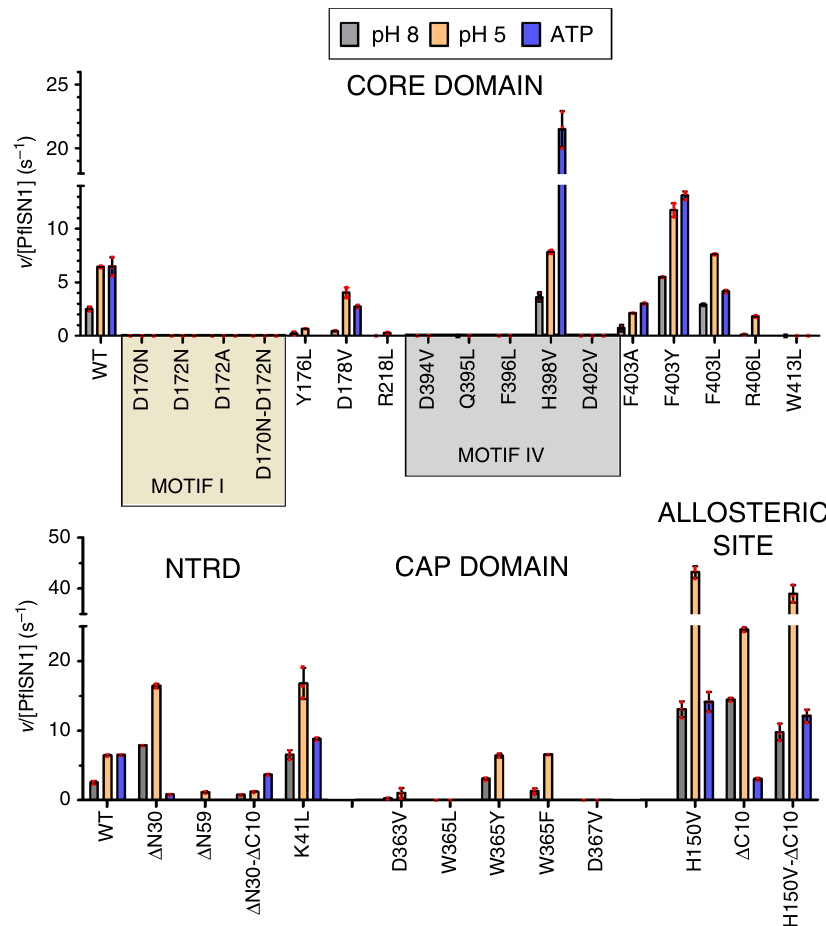
Fig. 3 IMP-hydrolytic activity of Pf ISN1 and mutants at pH 8.0 and pH 5.0 and with ATP. Histograms and error bars represent mean and SD, respectively, from three independent measurements. Location of mutations in Pf ISN1 is indicated above the histograms. v , the initial rate is the change in concentration of the product over time. NTRD, N-terminal regulatory domain. The concentration of enzyme and IMP used in all assays was 0.9 µ M and 10 mM, respectively. Concentration of ATP was 2 mM. The conditions used for the assays are as mentioned in Supplementary Methods. WT, wild-type. Source data are provided as a Source data fi